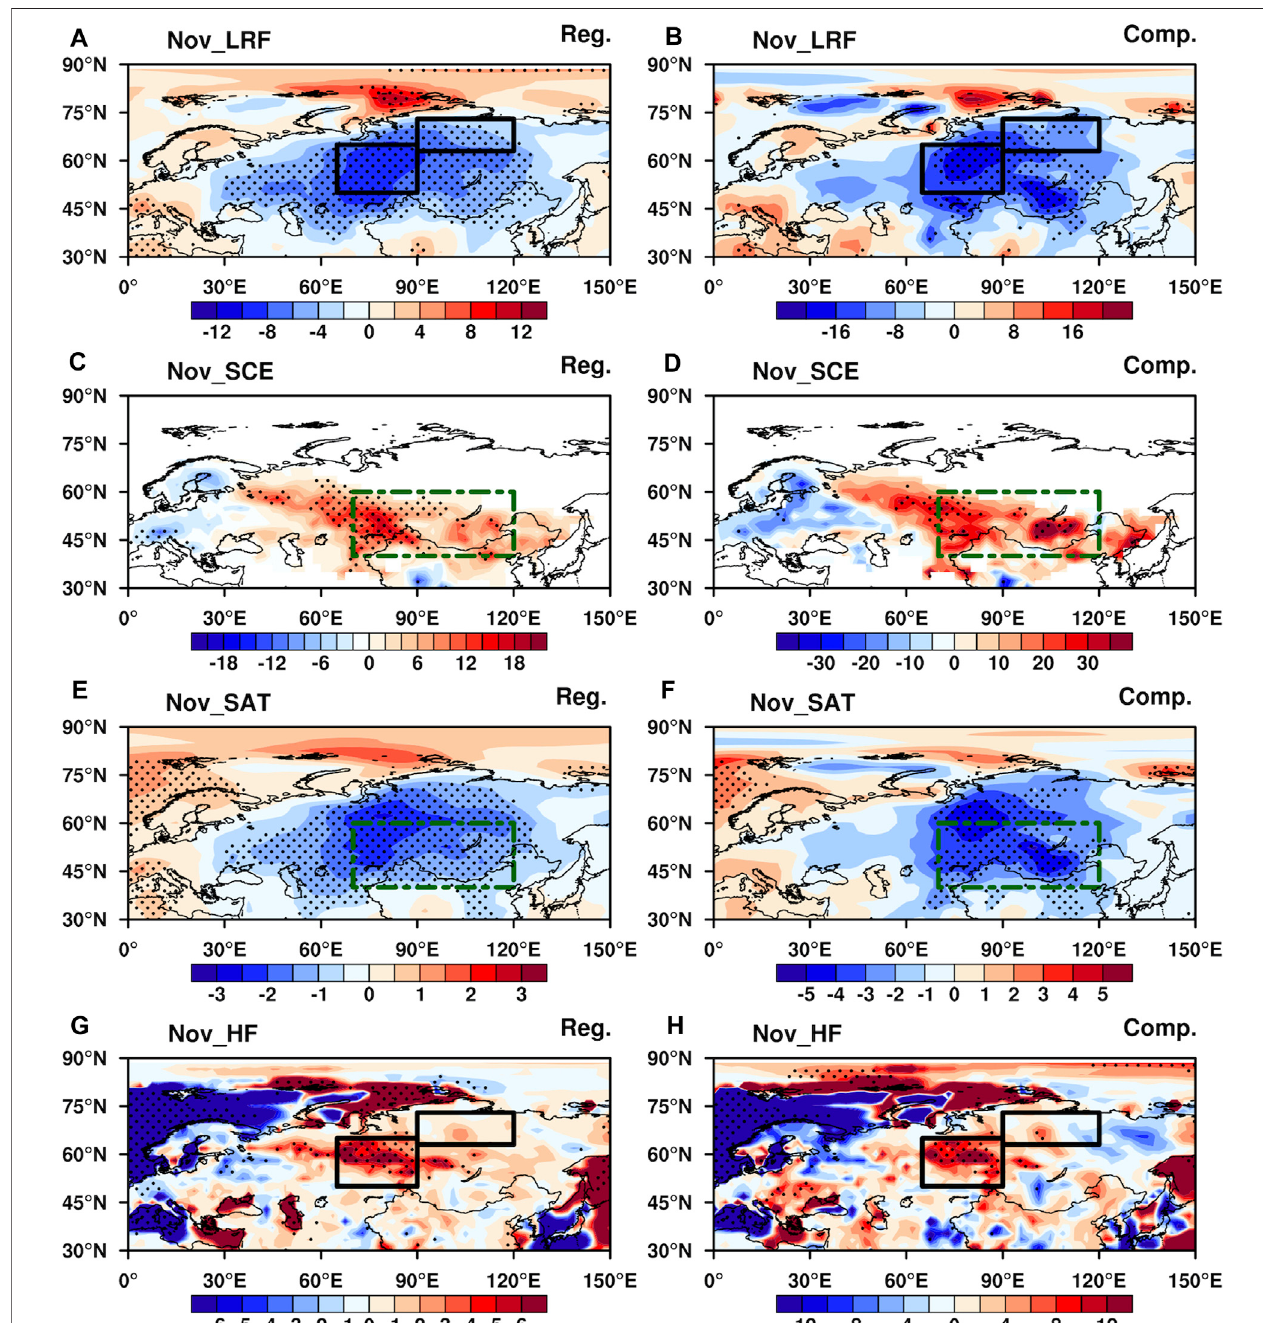
FIGURE 3 | (A, C, E, G) Regression of variables on the Siberian snow depth index (SSDI) and (B, D, F, H) results of composite differences in variables between SSD H – SHI + − and SSD L – SHI − + in November during 2000 – 2018: (A, B) upward long-wave radiation fl ux (units: W m − 2 ); (C, D) snow cover extent (SCE; units: %); (E, F) surface air temperature (SAT; units: ° C); (G, H) heat fl ux (units: W m − 2 ). Dotted regions are statistically signi fi cant at the 90% con fi dence level, based on the t -test. The black rectangle represents the key area of Siberian snow depth (SSD) [(50 ° – 65 ° N, 65 ° – 90 ° E), (63 ° – 73 ° N, 90 ° – 120 ° E)] in (A, B, G, H). The green dotted rectangle represents the key area of the Siberian high (SH) (40 ° – 60 ° N, 70 ° – 120 ° E) in (C – F).